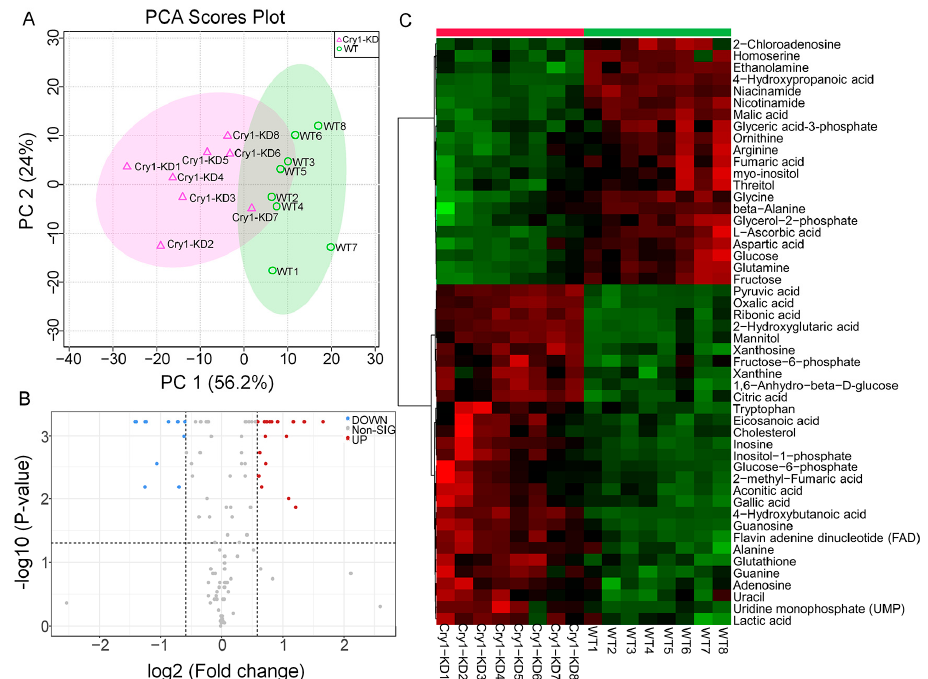
Figure 3. Differential metabolites based on LC-MS and GC-MS/MS metabolomics. ( A ) Principal component analysis; ( B ) volcano plot. The differential metabolites were screened out under the condition of fold change > 1.5 and FDR < 0.05; ( C ) heatmap of the top 50 differential metabolites. WT, wild-type cells; Cry1-KD, BmCry1 knockdown cells.